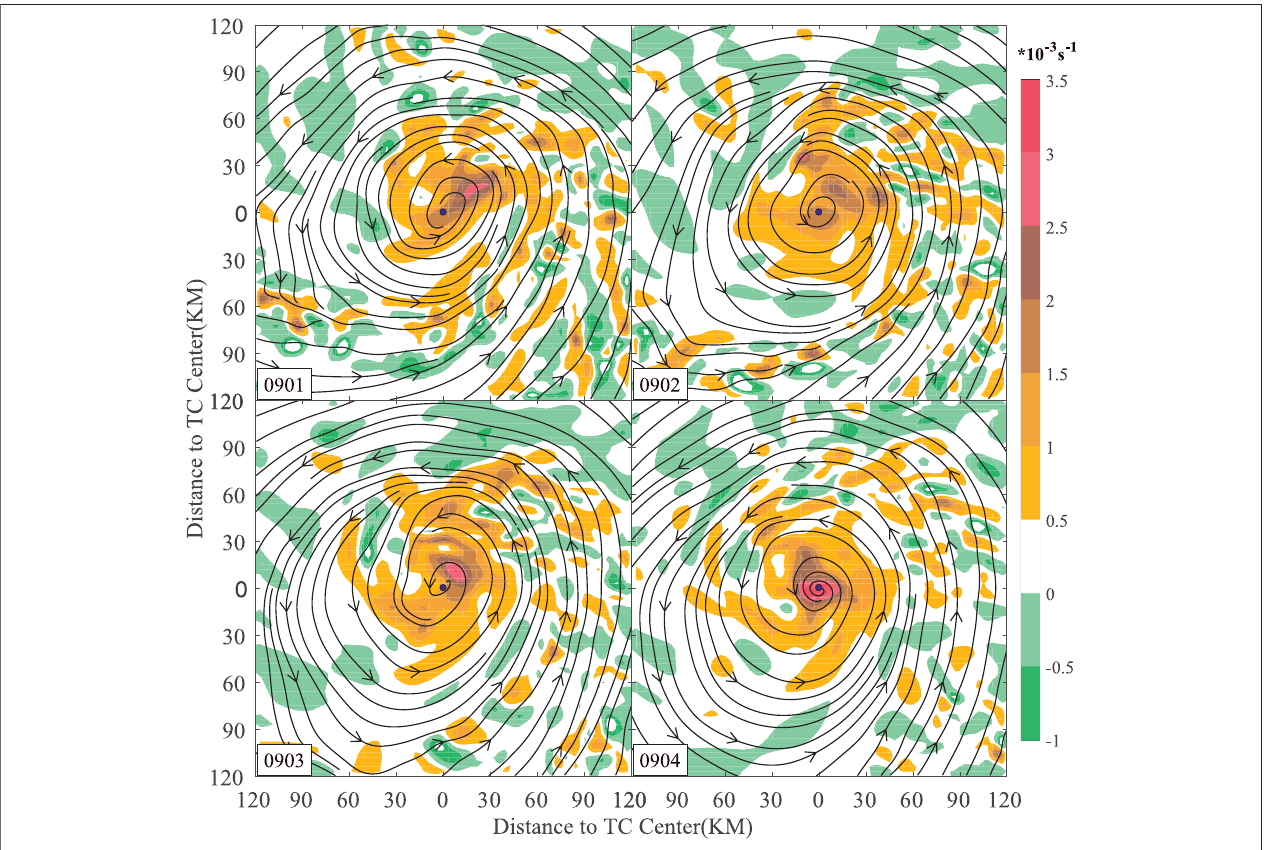
FIGURE 6 | Streamlines at 3 km and vorticity fi eld (color scale) of Meranti core region from 1:00 to 4:00 UTC September 9. The solid blue point represents the approximate center of Meranti.